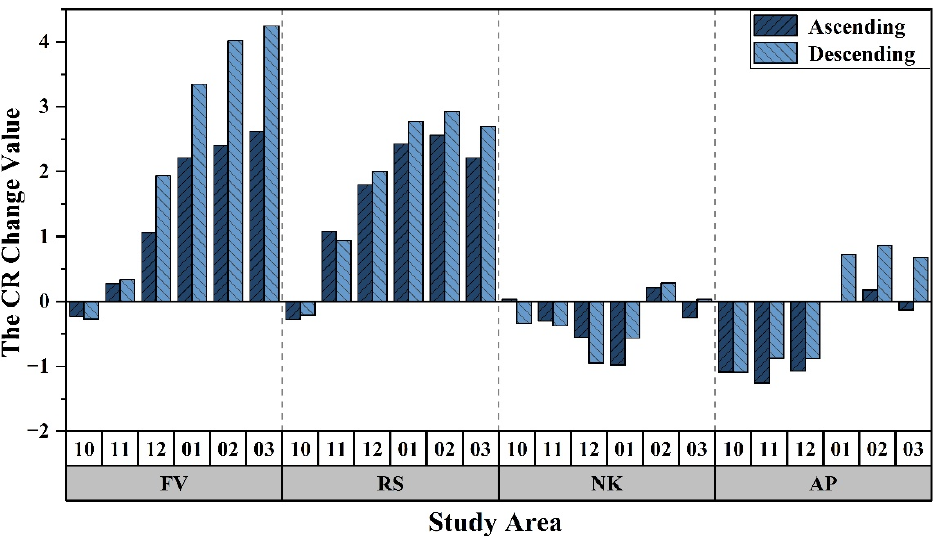
Figure 11. The monthly CR value difference between each month of 2019 snow season (October 2019–March 2020) and September 2019 for the ascending and descending orbits at the four typical study areas.